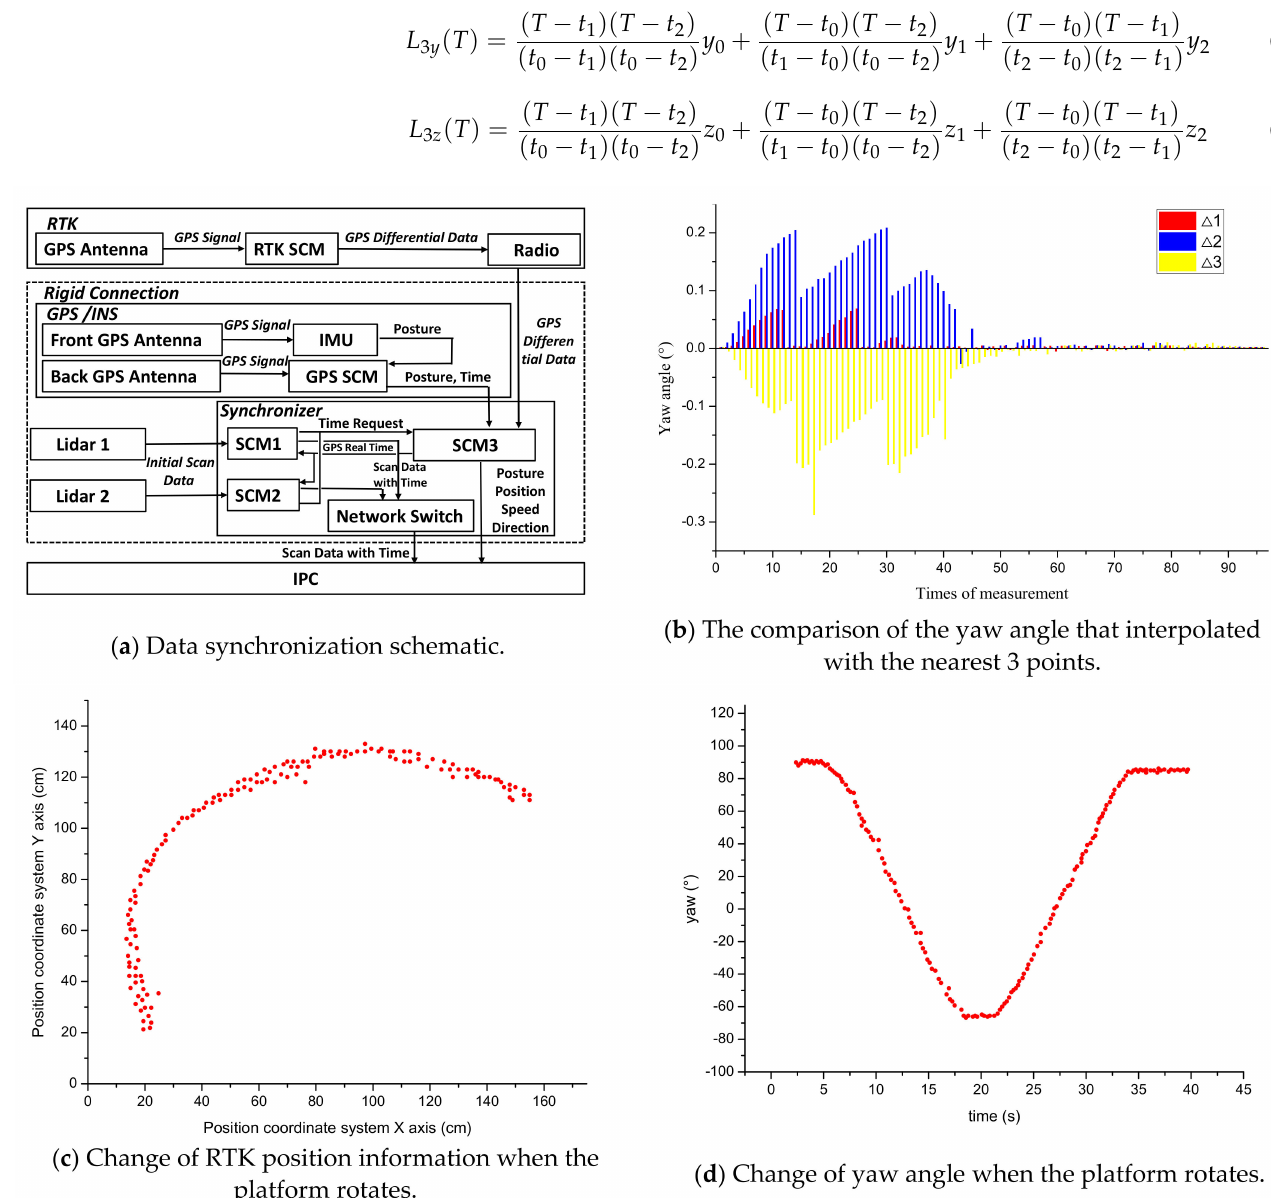
Figure 4. Data synchronization schematic and experimental result